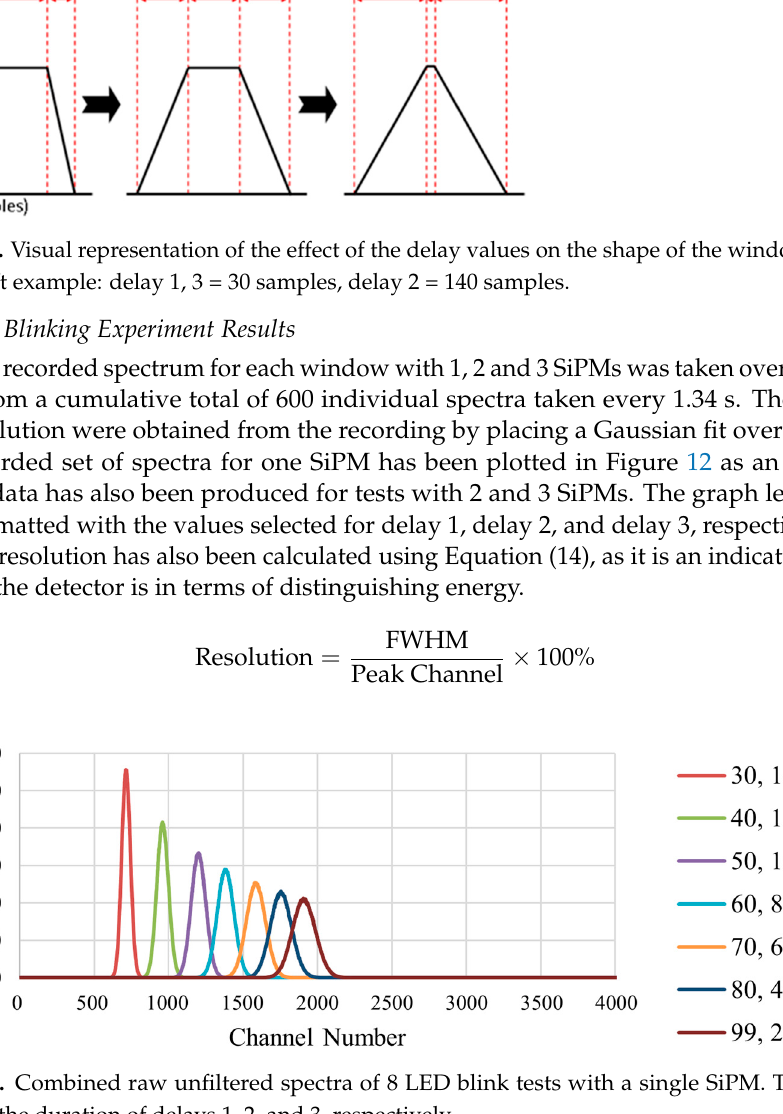
Figure 12. Combined raw un fi ltered spectra of 8 LED blink tests with a single SiPM. The legend indicates the duration of delays 1, 2, and 3, indicates the duration of delays 1, 2, and 3, respectively.